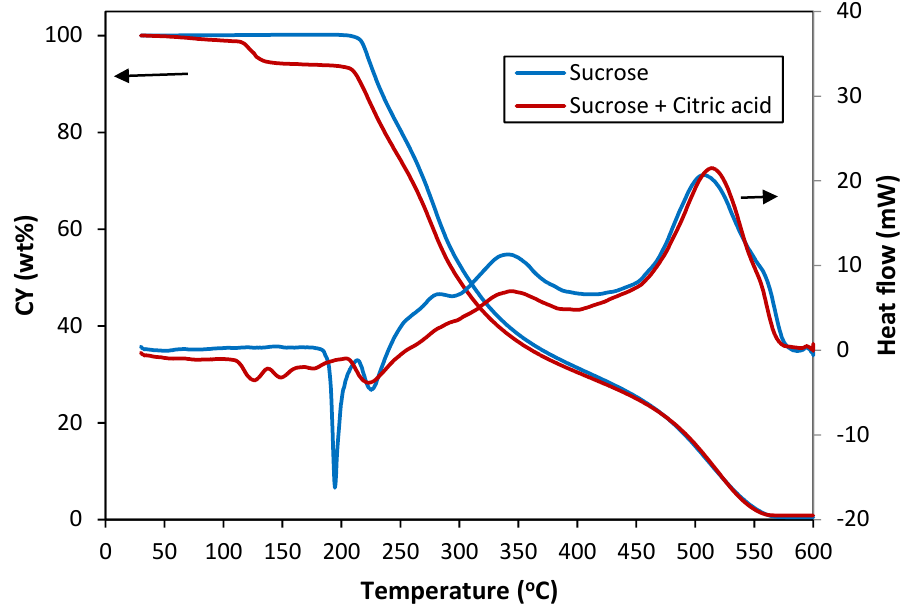
Figure 1. Weight loss (CY) and heat flow curves of sucrose and sucrose with citric acid in air atmos- phere.